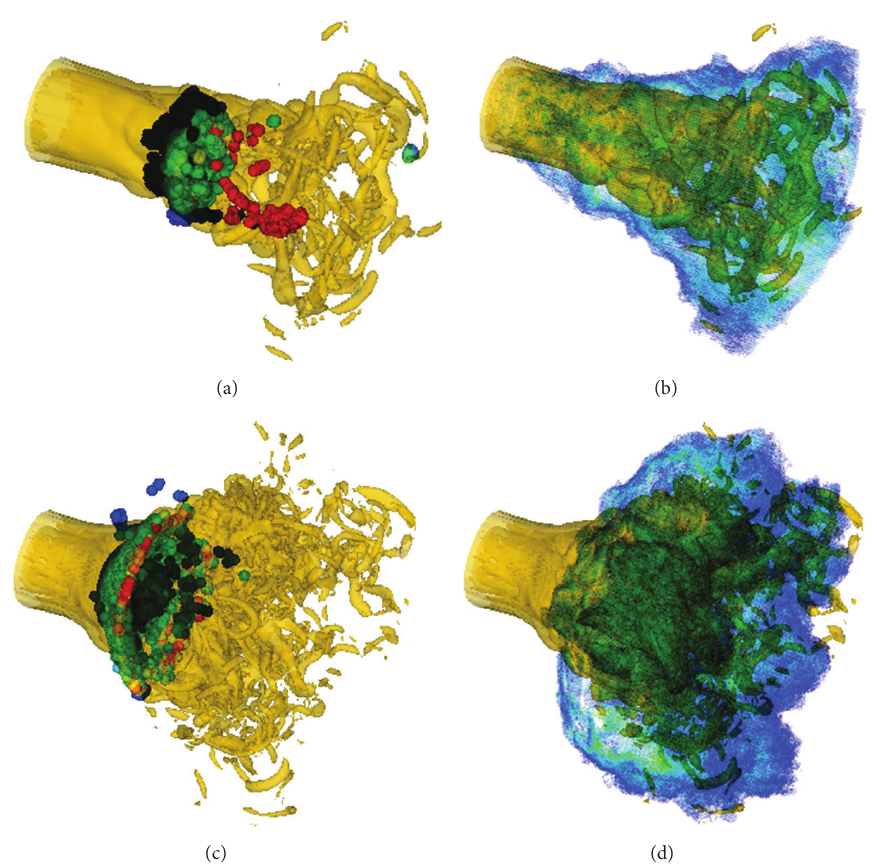
Figure 6: Locations of anisotropic turbulence dissipation ( |̃𝜀 1 /̃𝜀 3 | > 100) for 𝑆 1 = 0.28 (a) and 𝑆 3 = 0.59 (c) and locations of nearly isotropic turbulence dissipation ( −0.8 < log ̃𝜀 1 , log ̃𝜀 2 , log ̃𝜀 3 < 0.4 or 0.158 < ̃𝜀 1 , ̃𝜀 2 , ̃𝜀 3 < 2.5) for 𝑆 1 = 0.28 (b) and 𝑆 3 = 0.59 (d), respectively, in the background of